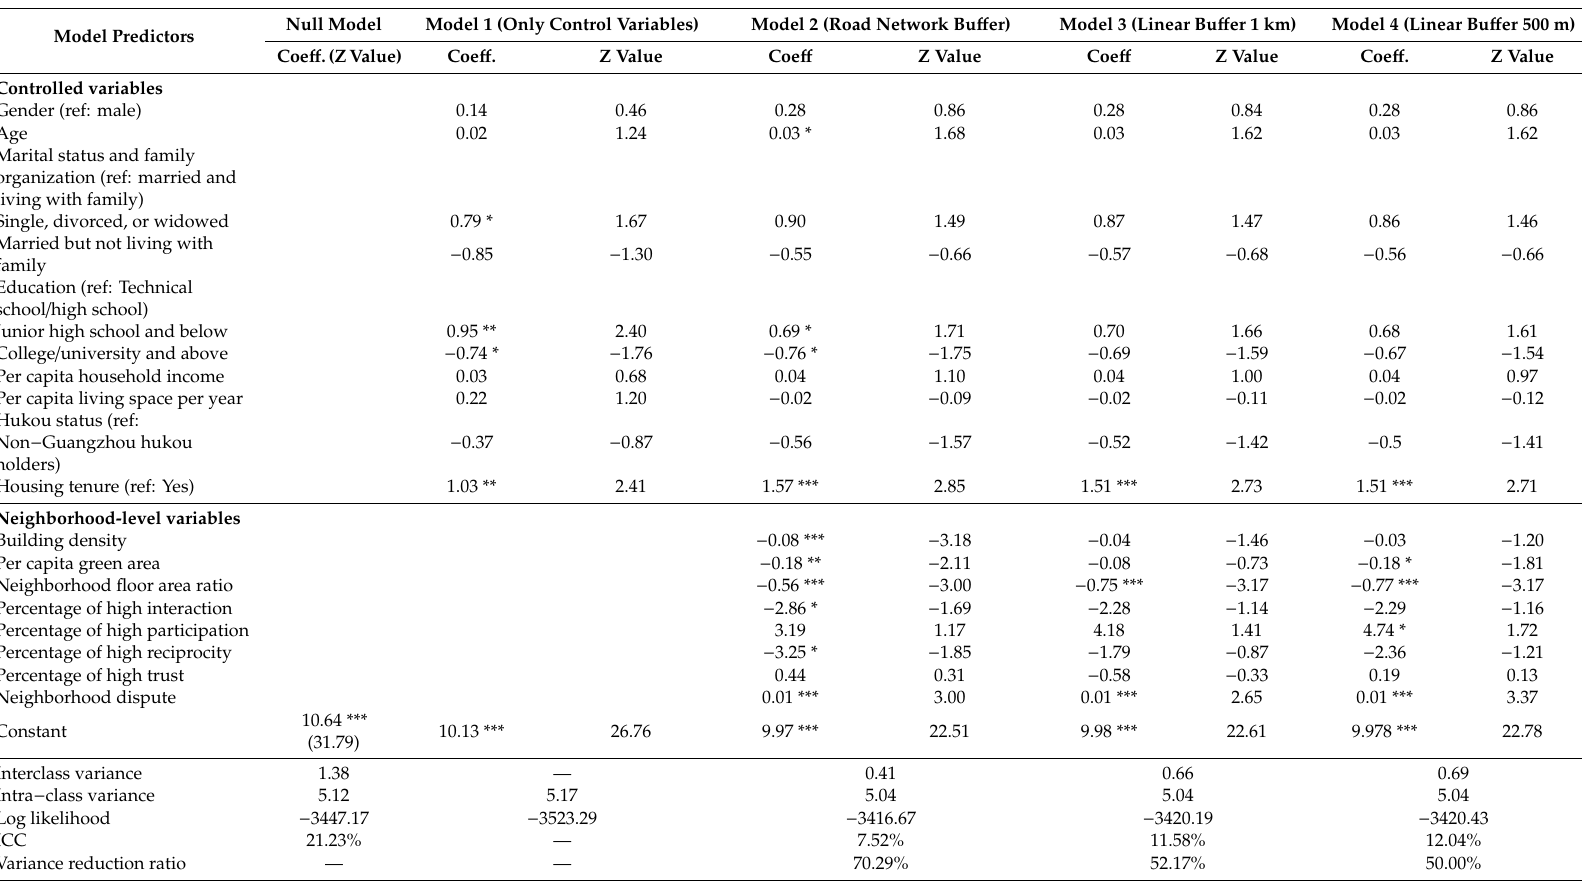
Table 2. Multilevel modeling on residents’ mental health in